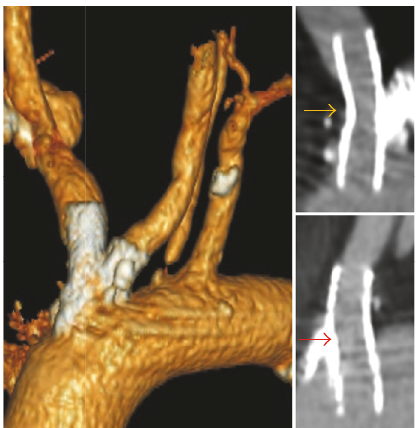
Figure 3: 3-month CT angiogram demonstrates excellent dilatation of the innominate (yellow arrow) and left common carotid artery (red arrow) in the supra-aortic